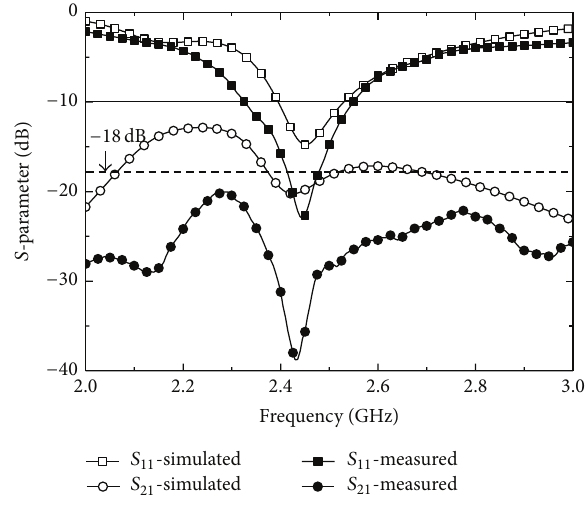
Figure 12: Simulated and measured 𝑆 -parameter results for the proposed antenna.